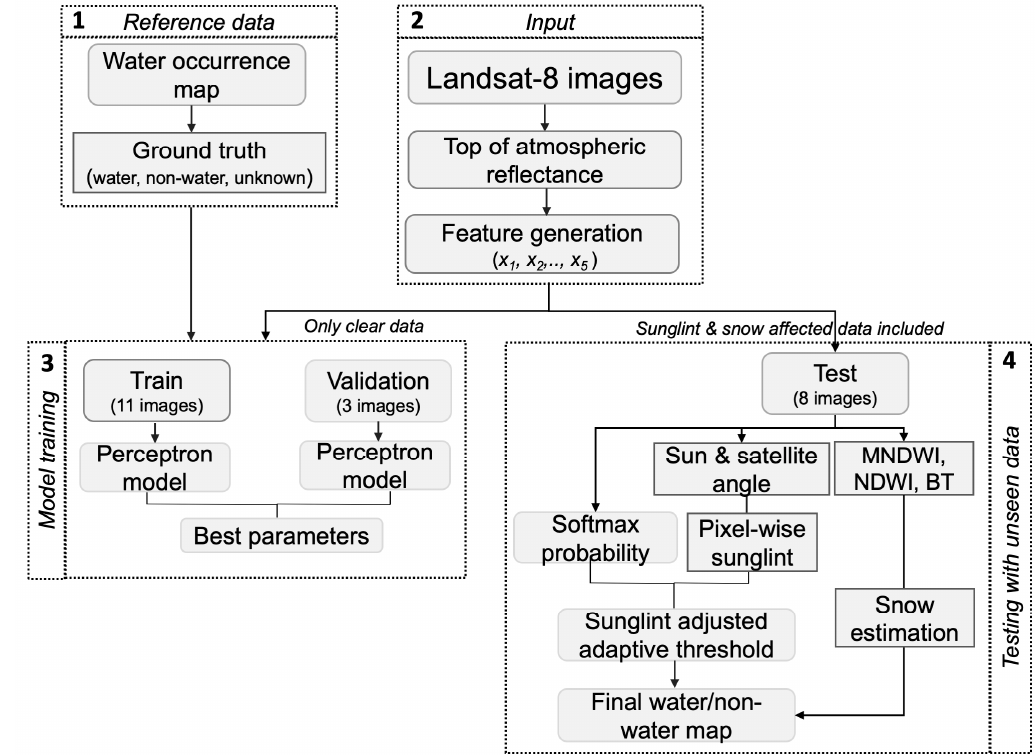
Figure 1. The workflow of proposed automatic water/non-water region estimation.